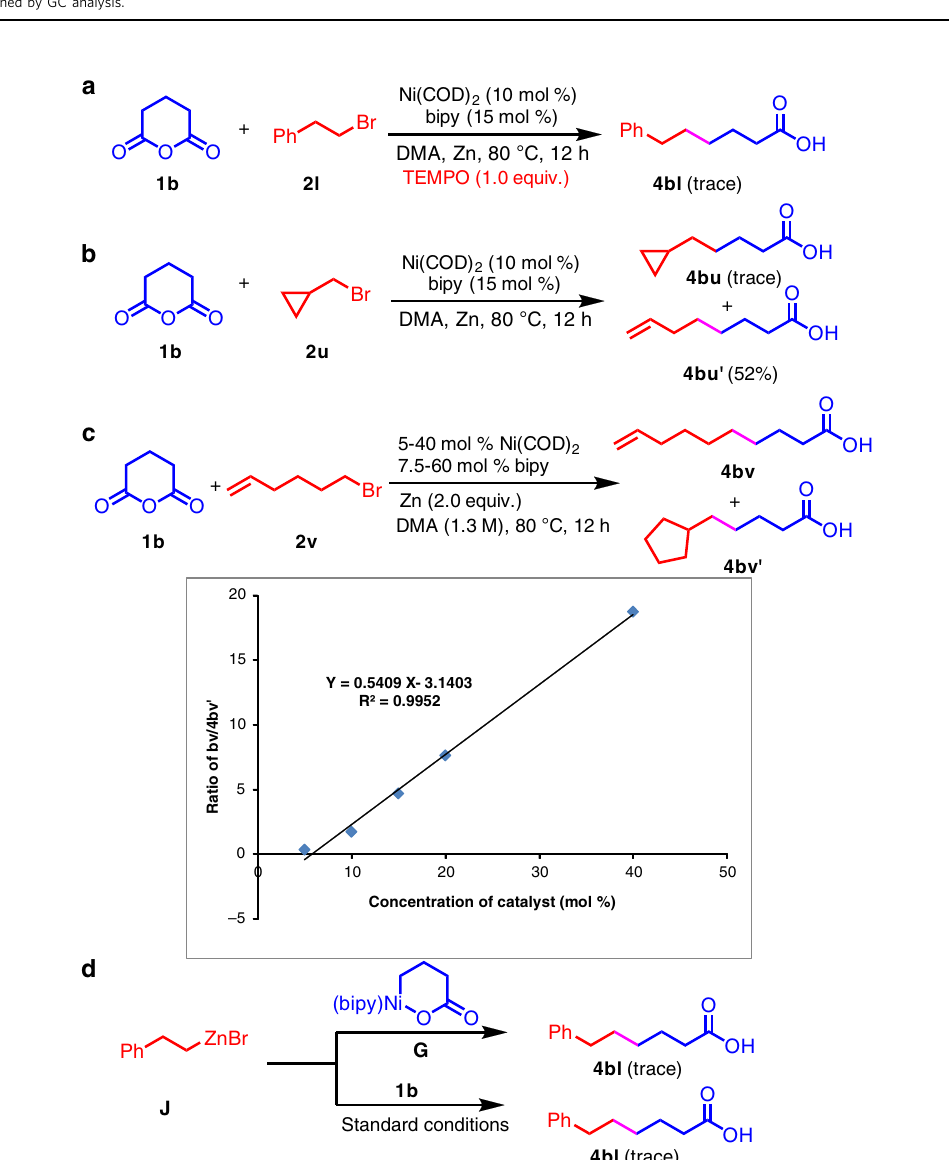
Fig. 5 Mechanistic studies. a Inhibition of the reaction in the presence of TEMPO. b Radical clock reaction leads to ring opening, suggestive of radical intermediates. c Dependence of the ratio of 4bv/4bv ’ on catalyst concentration, supporting a radical mechanism. d Demonstration that organozinc J is not a viable reaction